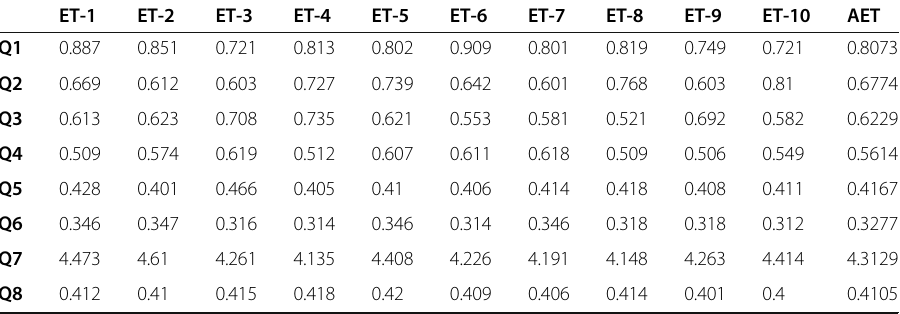
Table 14 Query execution time for Amazon EKS with Colorado State data for HC-2